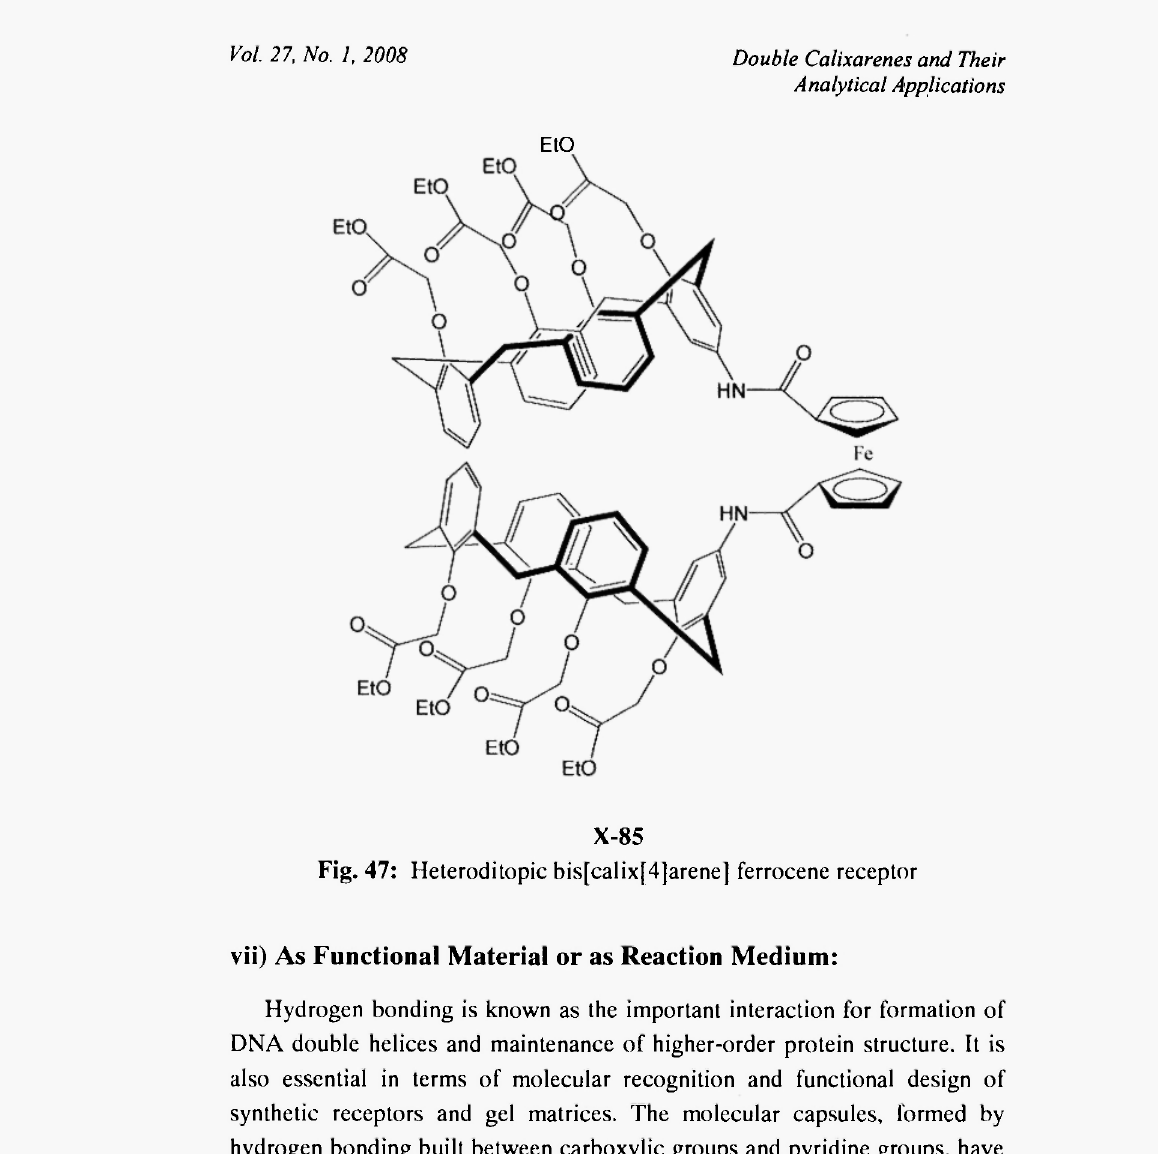
Fig. 47: Heteroditopic bis[calix[4]arene] ferrocene